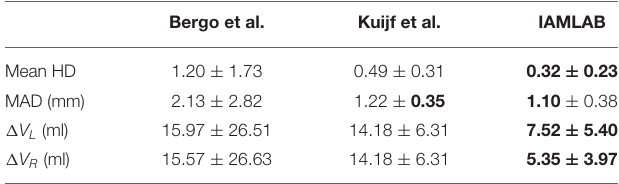
TABLE 3 | Mean ( ± std) validation metric for all methods over the entire validation dataset. Bergo et al. Kuijf et al. IAMLAB Mean